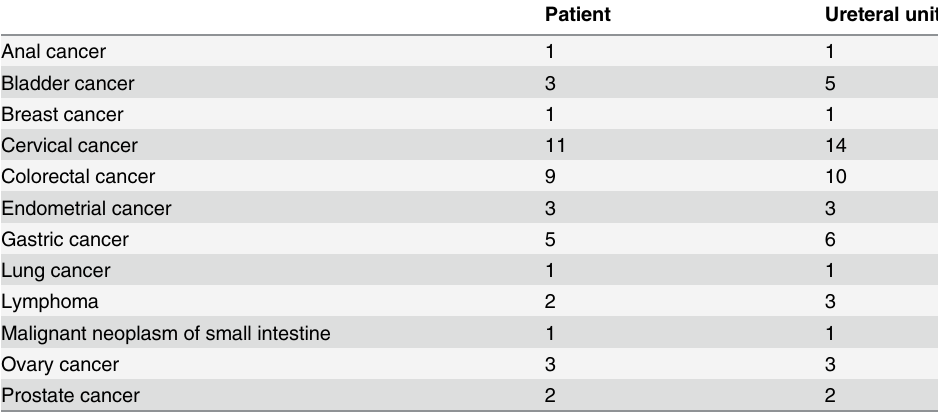
Table 1. The number of the patients, ureteral units, and stents according to type of malignancy.